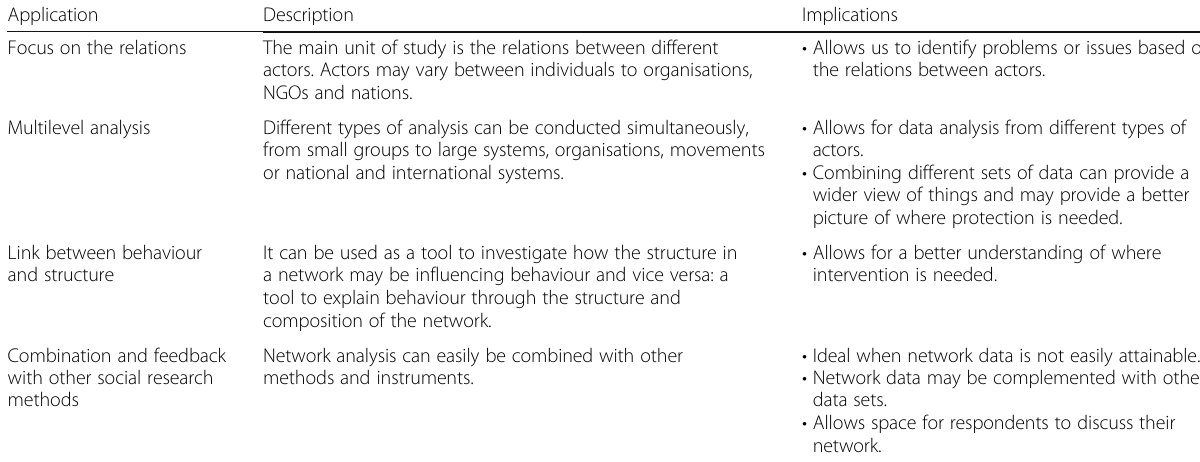
Table 1 Network analysis applications